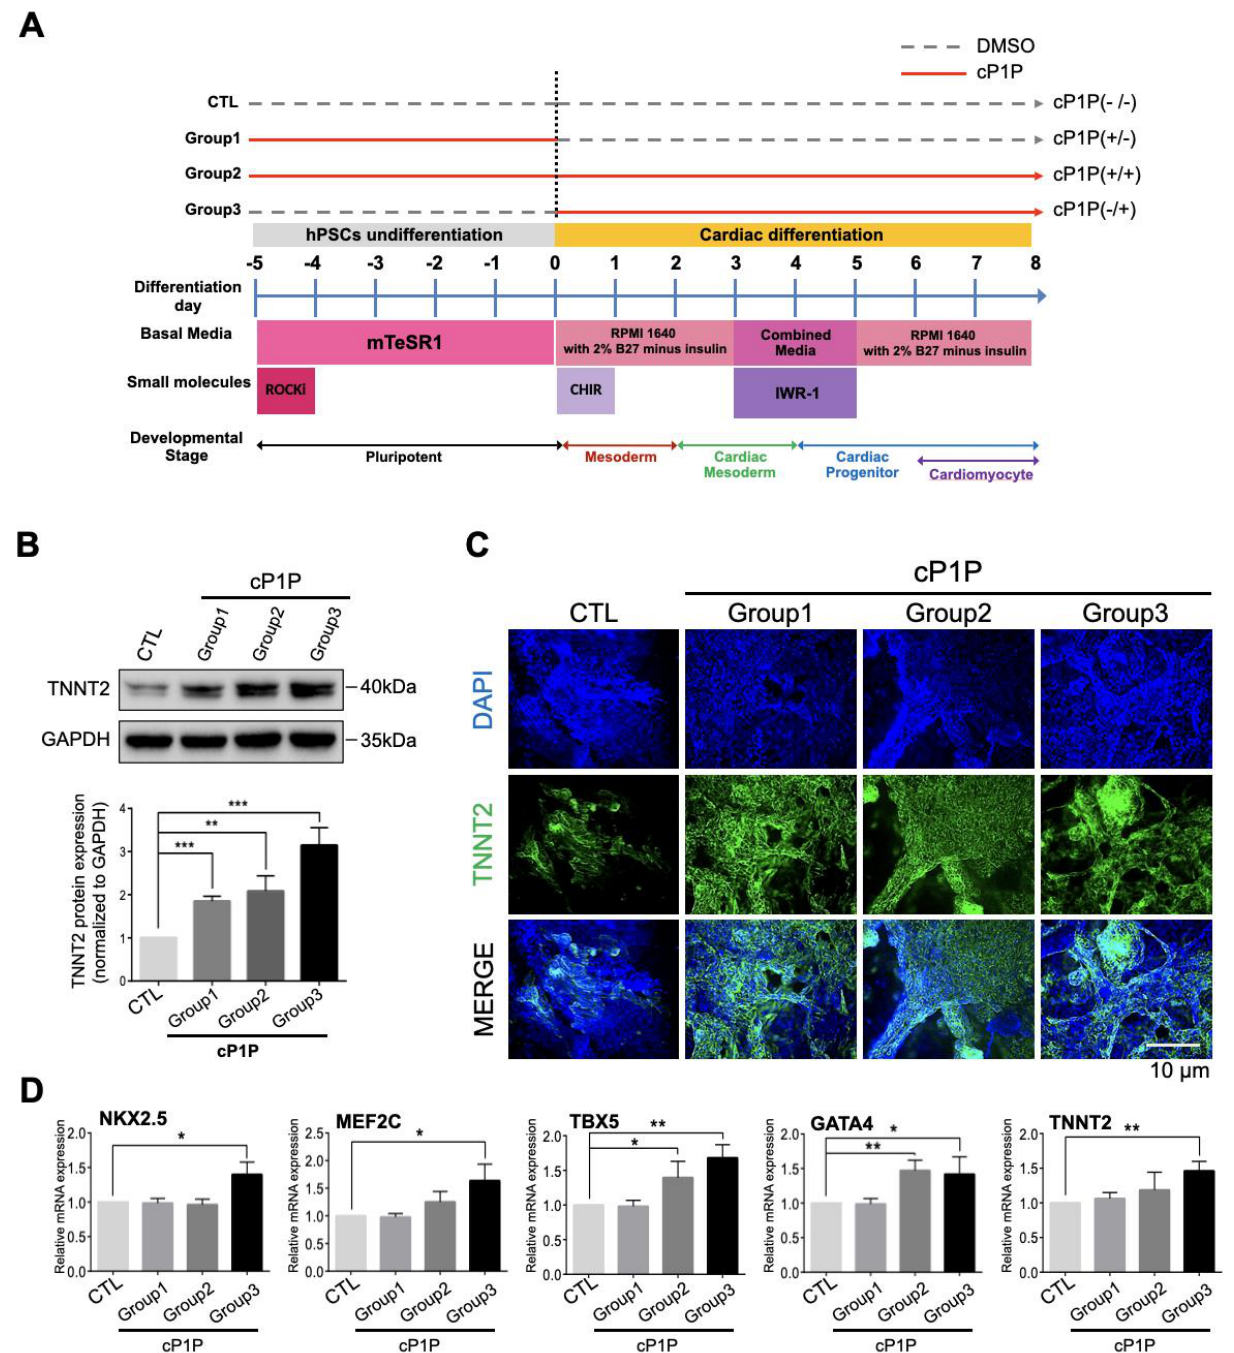
Figure 1. cP1P enhances cardiac differentiation in human embryonic stem cells. ( A ) Illustration of the chemically defined cardiac differentiation protocol utilized in this study. cP1P was administered during different stages of cardiac differentiation. Group 1 represents treatment with cP1P from days −5 to 0; Group 2, from days 5 to 8; and Group 3, from days 0 to 8 during differentiation. ( B ) Immunoblot analysis of the cardiomyocyte marker TNNT2 in Groups 1, 2, and 3 were analyzed at day 8 of cardiac differentiation. Graph represents the relative protein expression of TNNT2 as normalized to GAPDH ( n = 3, ** p < 0.01, *** p < 0.001). ( C ) Immunofluorescence analysis of the cardiomyocyte marker TNNT2 in Groups 1, 2, and 3 were analyzed at day 8 of cardiac differentiation, Scale bar = 10 μm. ( D ) Gene expression analysis of cP1P-treated cardiomyocytes by qRT-PCR at day 7 of cardiac differentiation showed higher expression levels of NKX2.5 , MEF2C , TBX5 , GATA4 , and TNNT2 in Group 3 when compared to their respective controls. Data are presented as the means ± SDs of three independent experiments ( n = 3, * p < 0.05, ** p < 0.01).